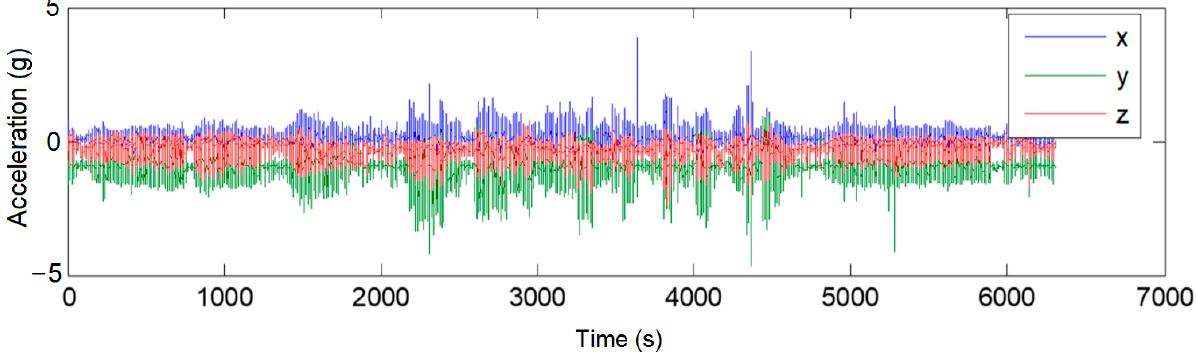
Figure 4. Diagram of source data.